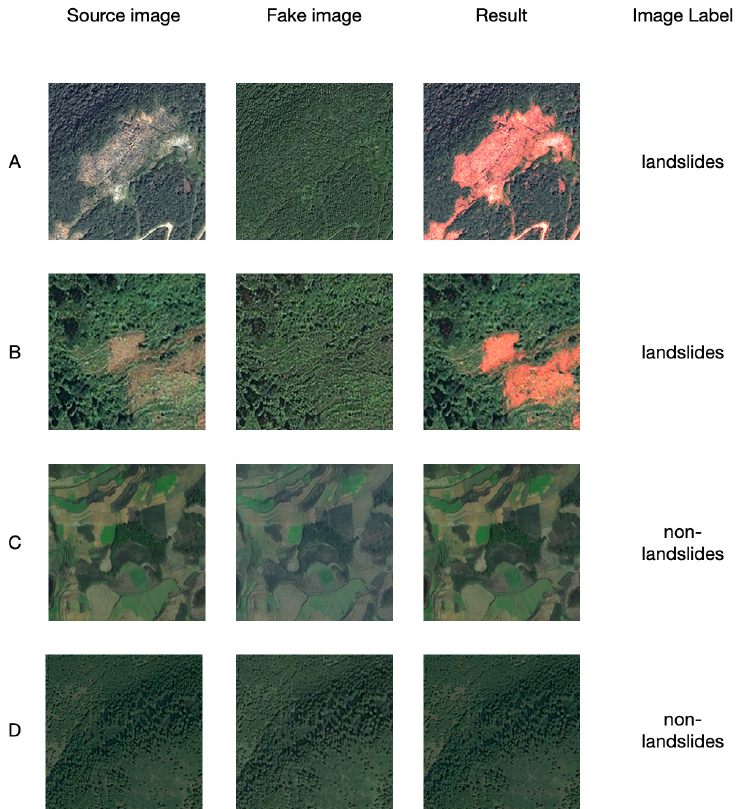
Figure 6. Segmentation results of cycleGAN method. We have used 4 samples for test. ( A , B ) are the landslides samples, ( C , D ) are the non-landslides samples. The results show that the 4 samples are all segmented correctly.